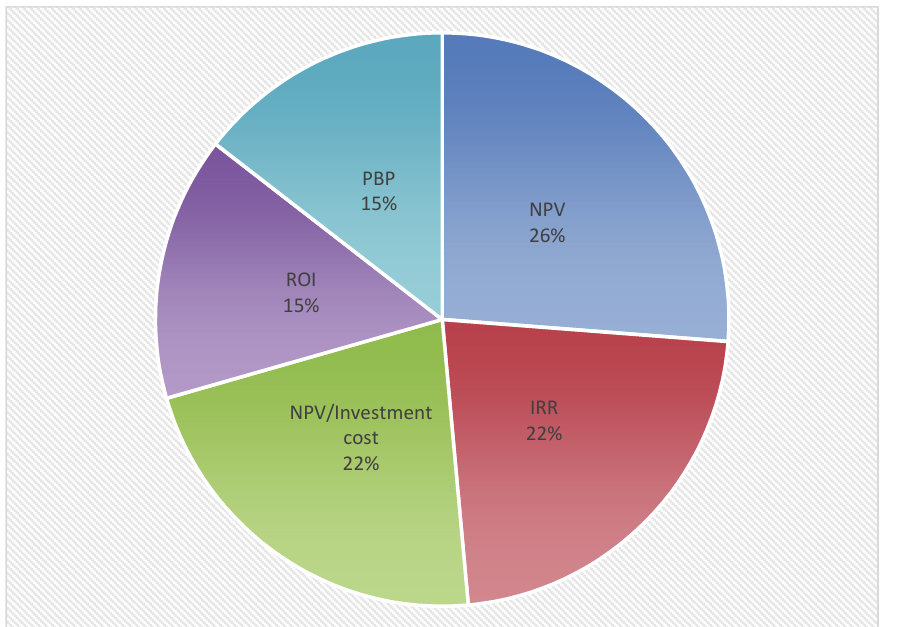
Fig. 5. Weight obtained for financial criteria using expert choice software (CR =